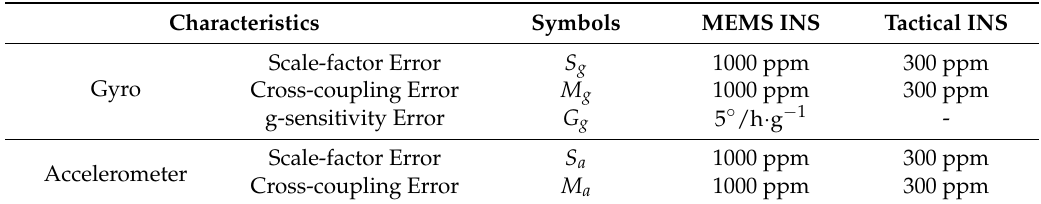
Table 2. Maneuver-dependent error specifications of different grades of